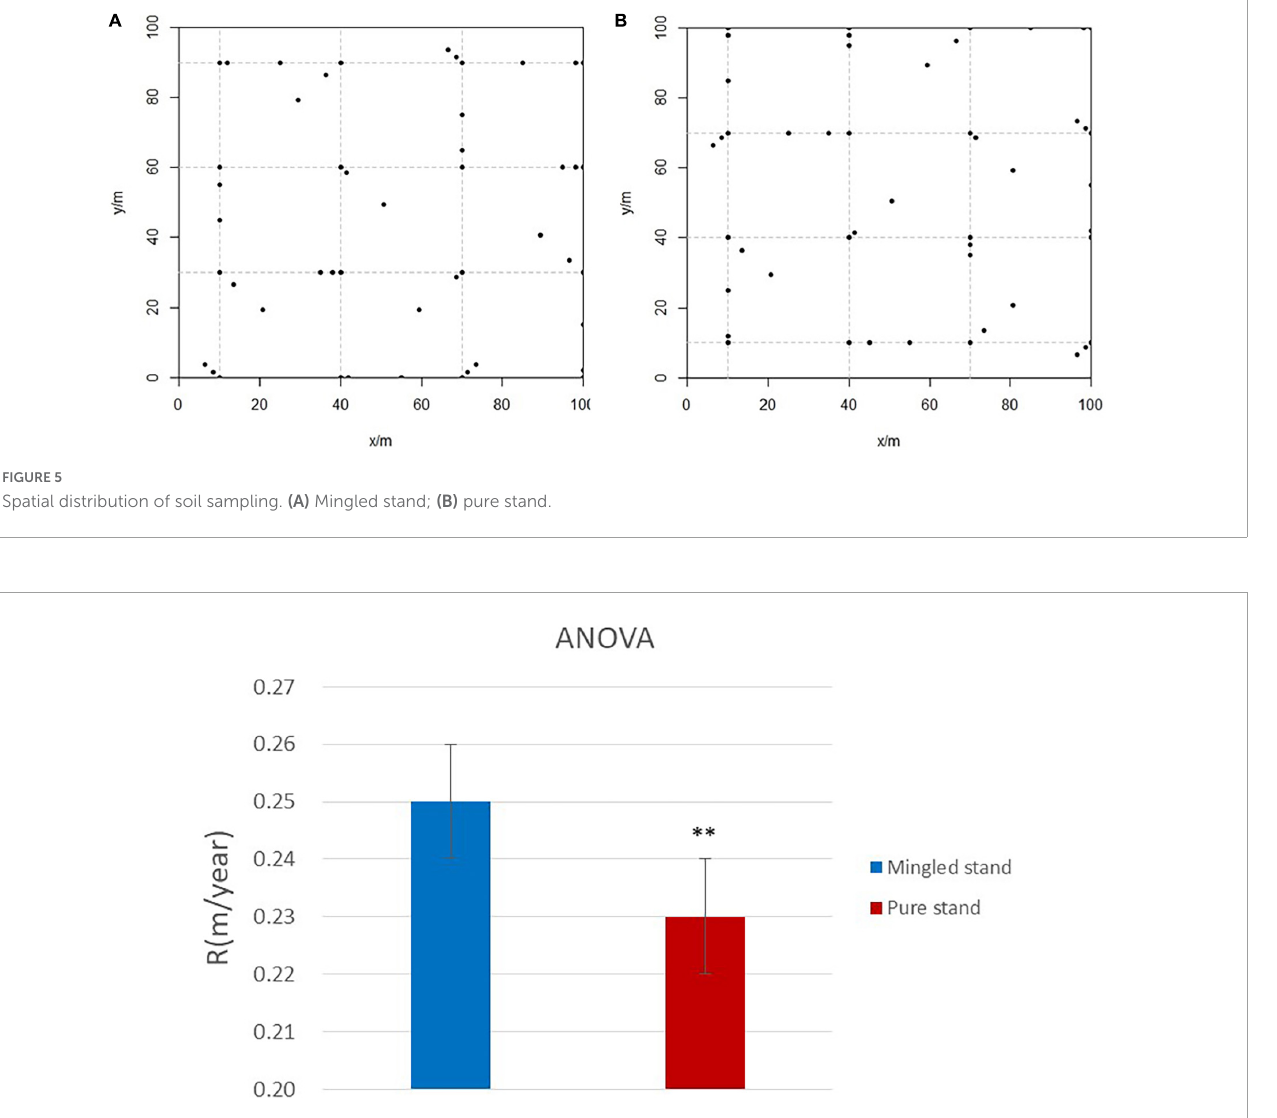
FIGURE6 Results of ANOVA. ∗∗ p < 0.01. R is the maximum growth rate of R. pseudoacacia